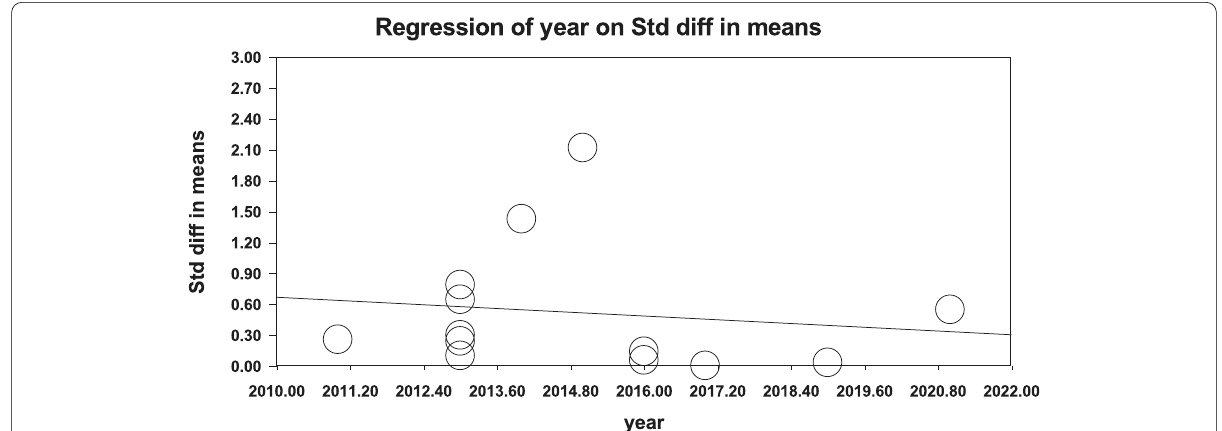
Fig. 6 The meta-regression of the relationship between the year of the publication and the standardized mean difference before and after the intervention in the control and intervention groups